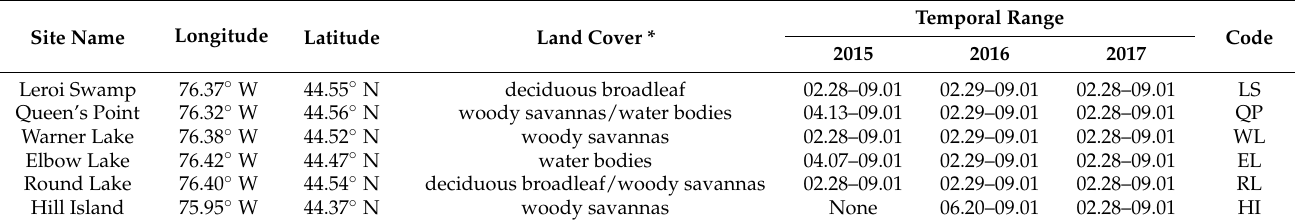
Table 1. Characteristics of the six QUBS sites for flooding seasons between 2015 and 2017. Site Name